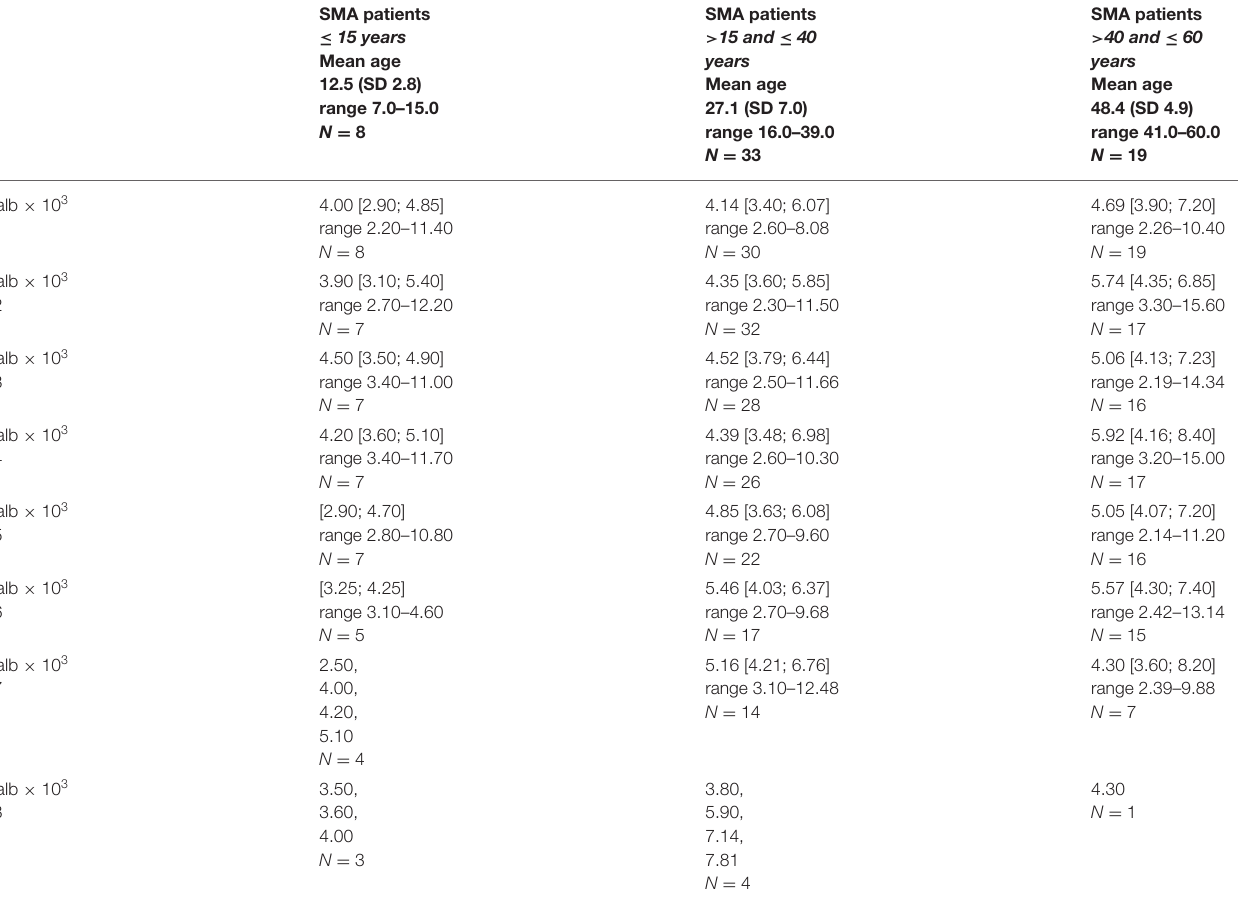
TABLE 3 | Illustration of Qalb levels within age